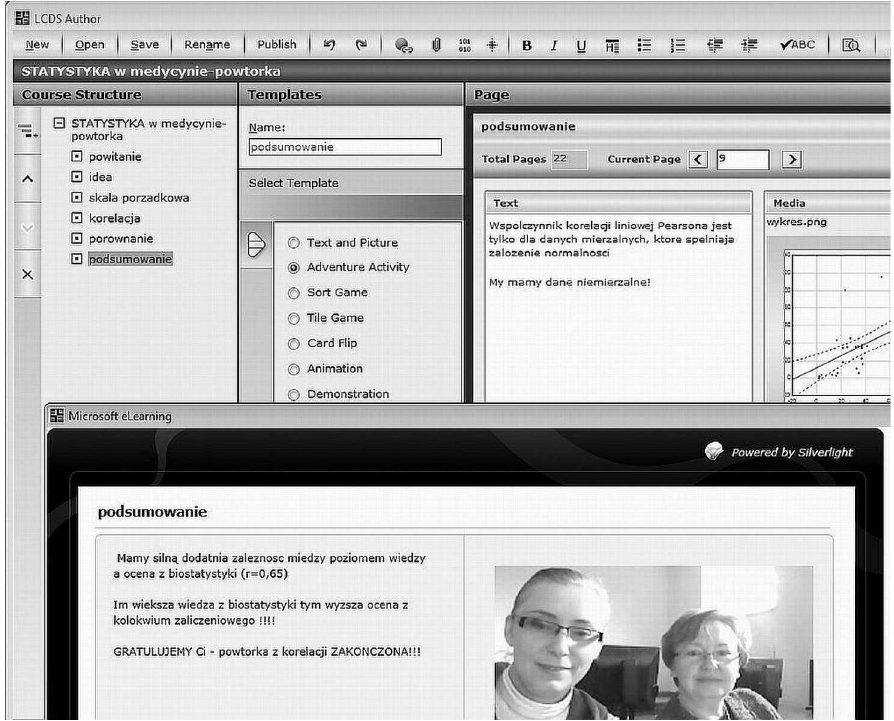
Figure 8. Creating an Adventure Activity in LCDS for Polish medical